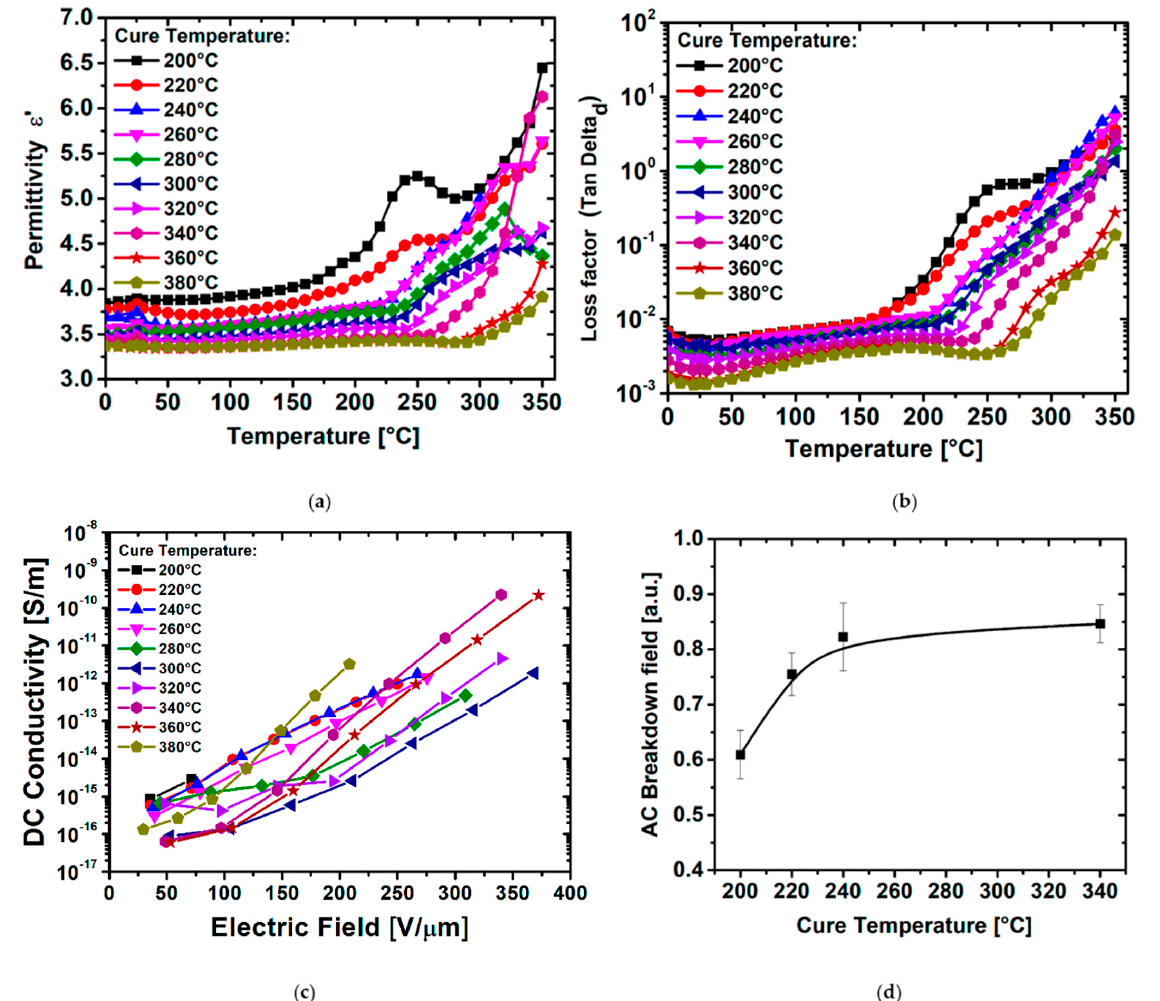
Figure 5. ( a ) Dielectric permittivity and ( b ) dielectric loss factor at 1 kHz vs. temperature. ( c ) DC conductivity vs. electric field for different PI imidization temperatures. ( d ) Dielectric breakdown field of PI films vs. imidization temperature.